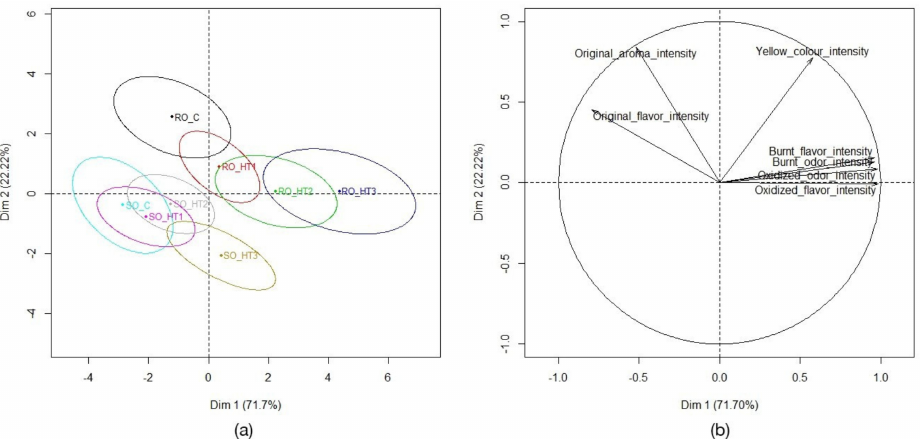
Figure 1. The results of PCA of the quantitative descriptive analysis of fortified oils before and after heat treatments: ( a ) Confidence ellipses for the mean points (RO_C, rapeseed oil control; RO_HT1, rapeseed oil samples after 1st heat treatment; RO_HT2, rapeseed oil samples after 2nd heat treatment; RO_HT3, rapeseed oil samples after 3rd heat treatment; SO_C, sunflower oil control; SO_HT1, sunflower oil after 1st heat treatment; SO_HT2, sunflower oil after 2nd heat treatment; SO_HT3, sunflower oil after 3rd heat treatment). ( b ) Variables factor